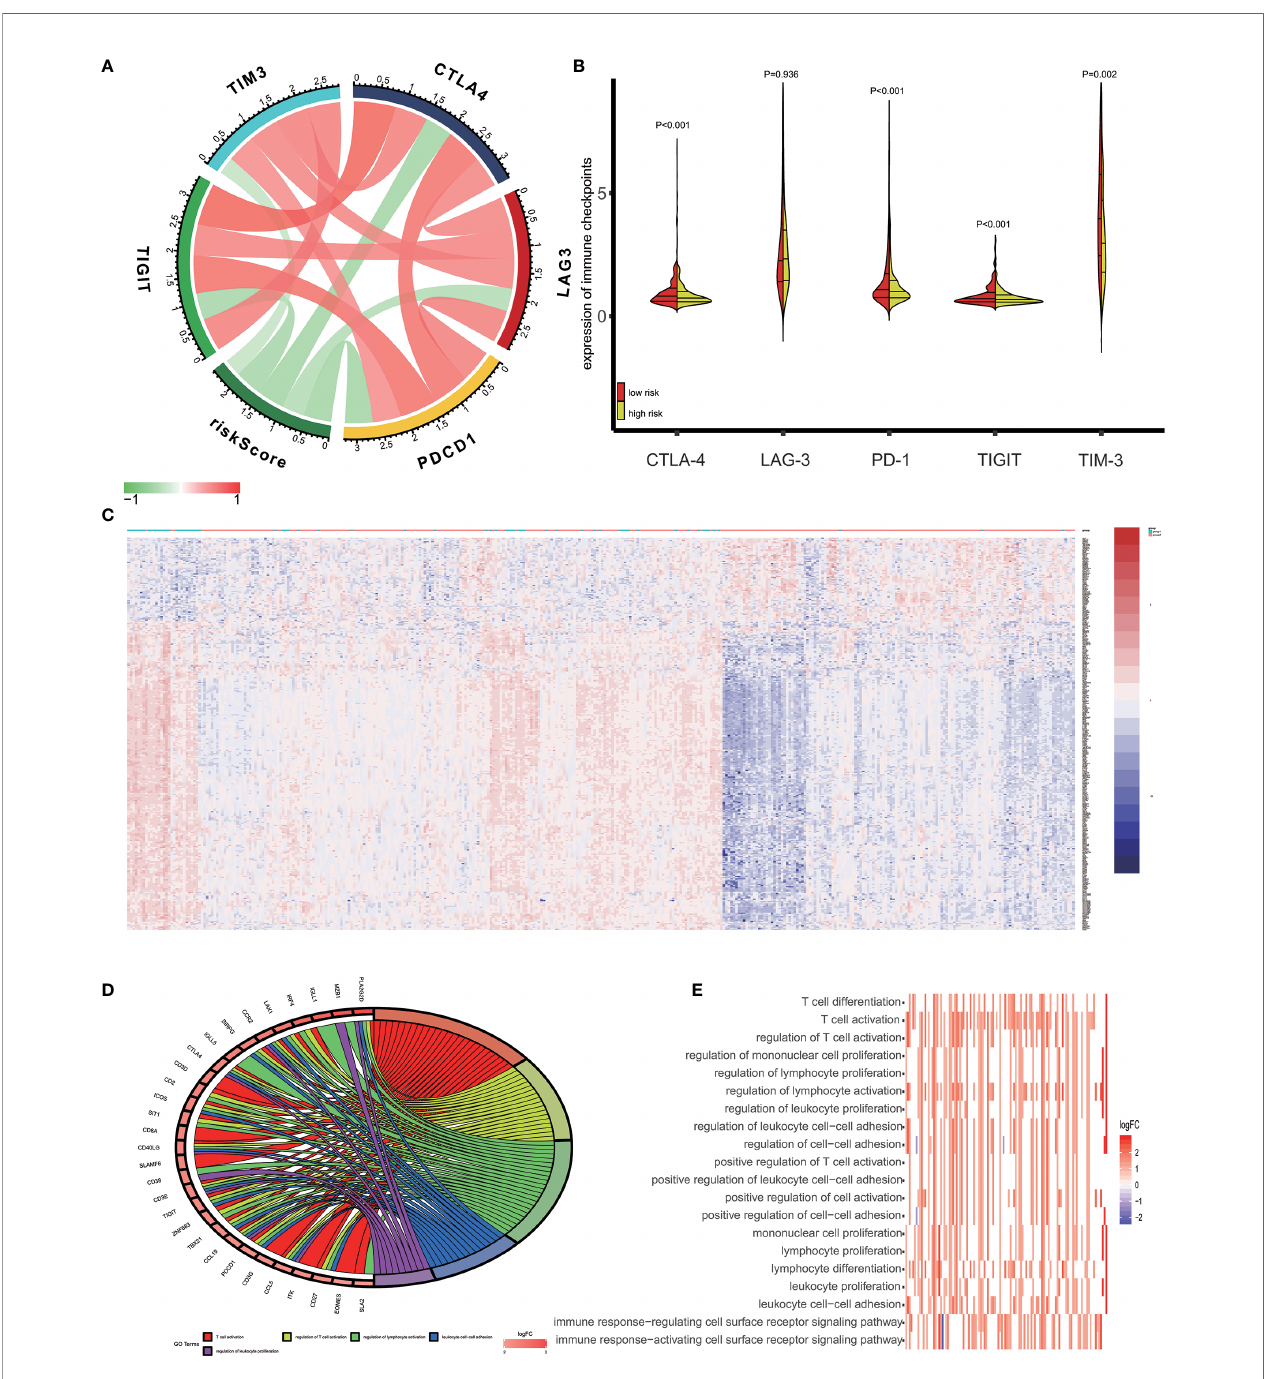
FIGURE 6 | Enrichment analysis of the immune prognostic model. (A) Correlation between expression of several prominent immune checkpoints and risk scores. (B) Comparison of the expression of selected immune checkpoint in high and low risk groups. (C) Heatmap of differentially expressed genes in high and low risk groups. (D) Circular plot of the biological processes enriched for the immune genes. (E) GO enrichment